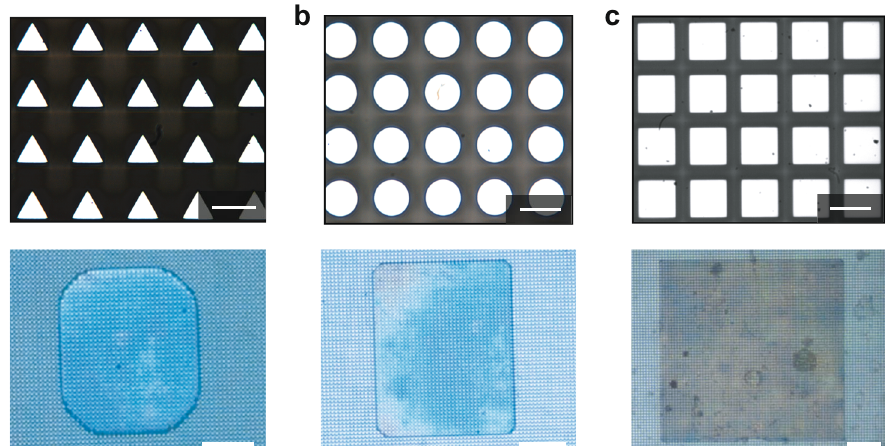
Fig. 4 Resolution of the droplet patterns on micropillar surfaces with various pillar spacings. From ( a – c ), b = 11 μ m, 8 μ m, and 7 μ m, respectively. By approaching H c , the corners of the droplet patterns gradually sharpened. Scale bar of the pillars, 20 μ m. Scale bar of the droplet patterns, 500 μ m.